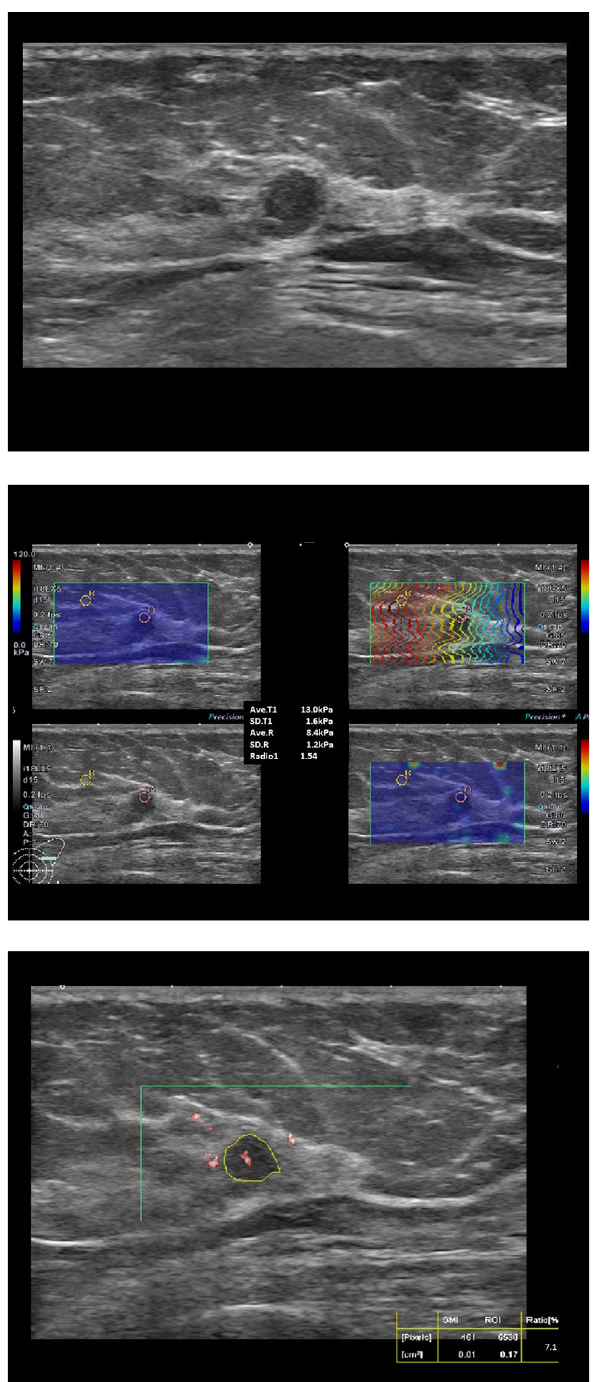
Figure 4. DCIS in a 50-year-old female patient. ( A ) B-mode ultrasound showed a 0.6 m-sized, mass categorized as C4a. ( B ) The lesion had soft elasticity measured below the cutoff values as SWEmax 13.0 kPa and SWEratio 1.54. ( C ) The SMI vascular index was measured at 7.1%, over the cutoff value. The combined score was 3, representing a benign lesion, but the pathologic diagnosis was DCIS,